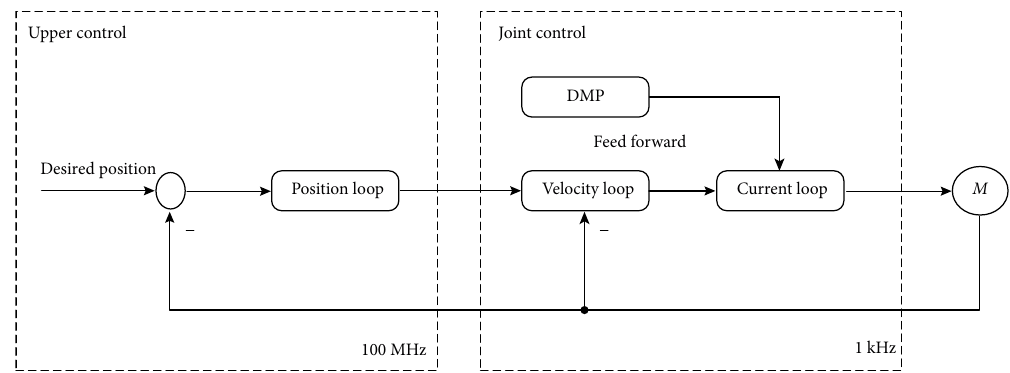
Figure 6: The block diagram of controll system.